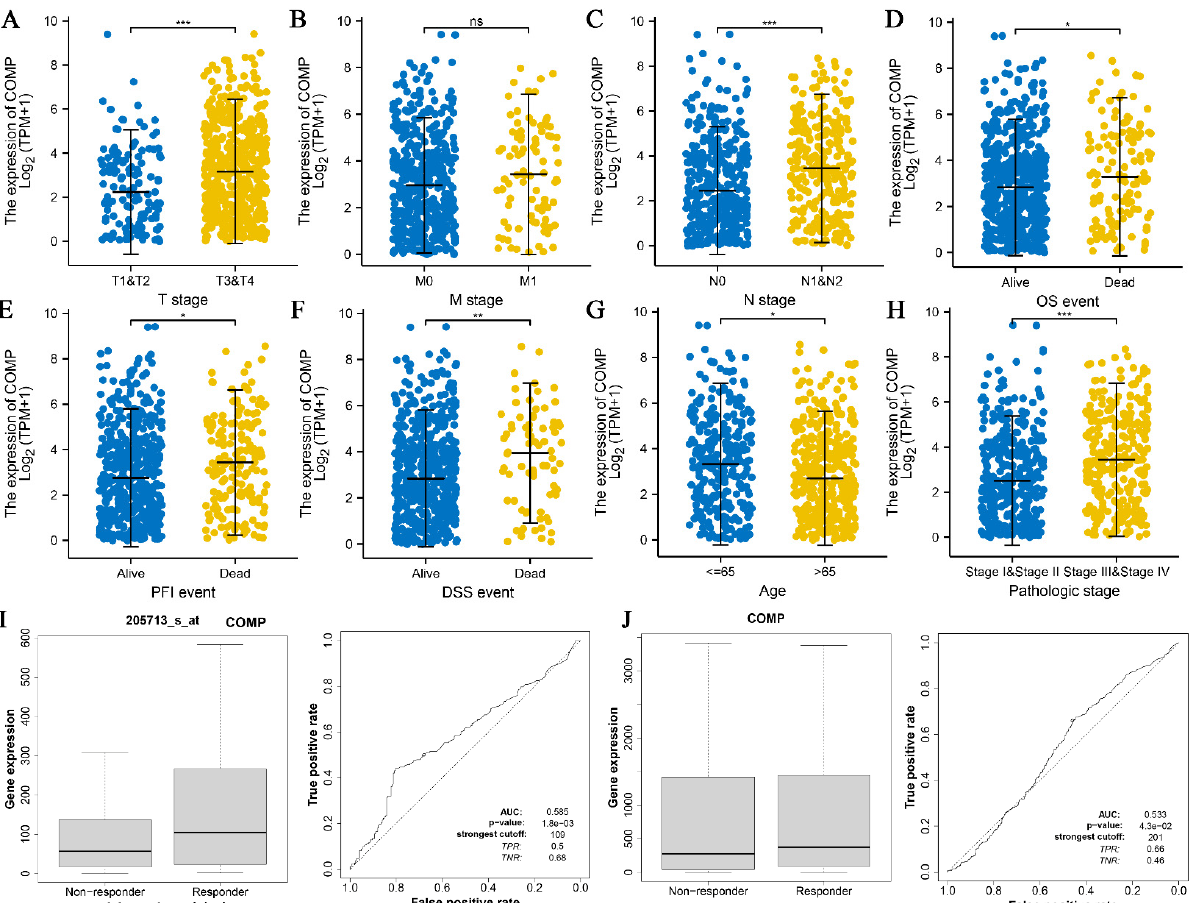
Figure 4. The correlation between COMP and clinical features of CRC patients. The correlation be- tween COMP and ( A ) T stage, ( B ) M stage, ( C ) N stage, ( D ) overall survival (OS) event, ( E ) progres- sion-free interval (PFI) event, ( F ) disease-specific survival (DSS) event, (G) patient age, ( H ) patho- logic stage, ( I ) response to chemotherapy, and ( J ) response to immunotherapy. * P < 0.05, ** P < 0.01, *** P <